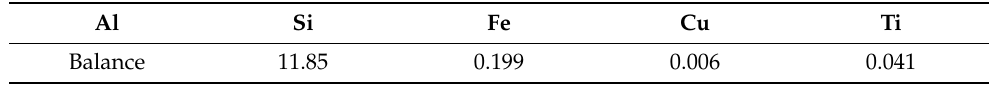
Figure 1. ( a ) Sample cut-off scheme; ( b ) deposition strategy; ( c ) additive-manufactured wall; ( d ) tensile sample with dimensions 1—AA7075 substrate; 2—as-deposited AA4047; 3—metallographic specimen; 4—tensile sample; 5–7—corrosion test samples. Table 1. Chemical composition of AA4047 wire.